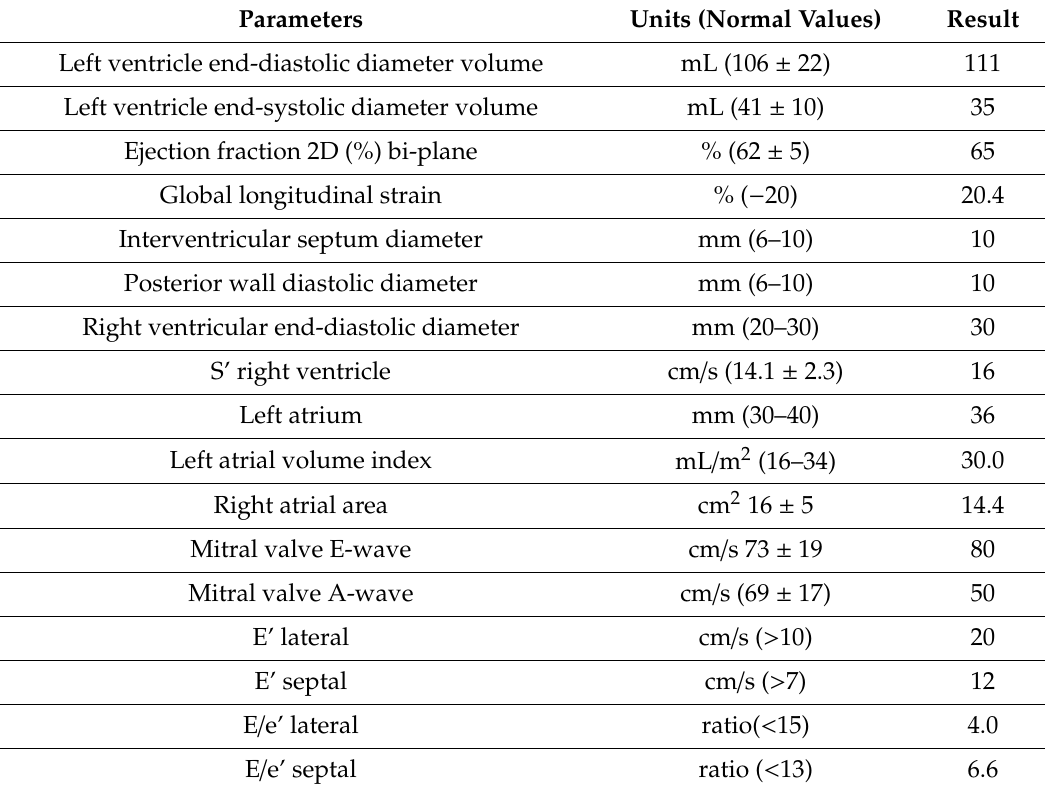
Table 3. Heart systolic and diastolic function in echocardiographic